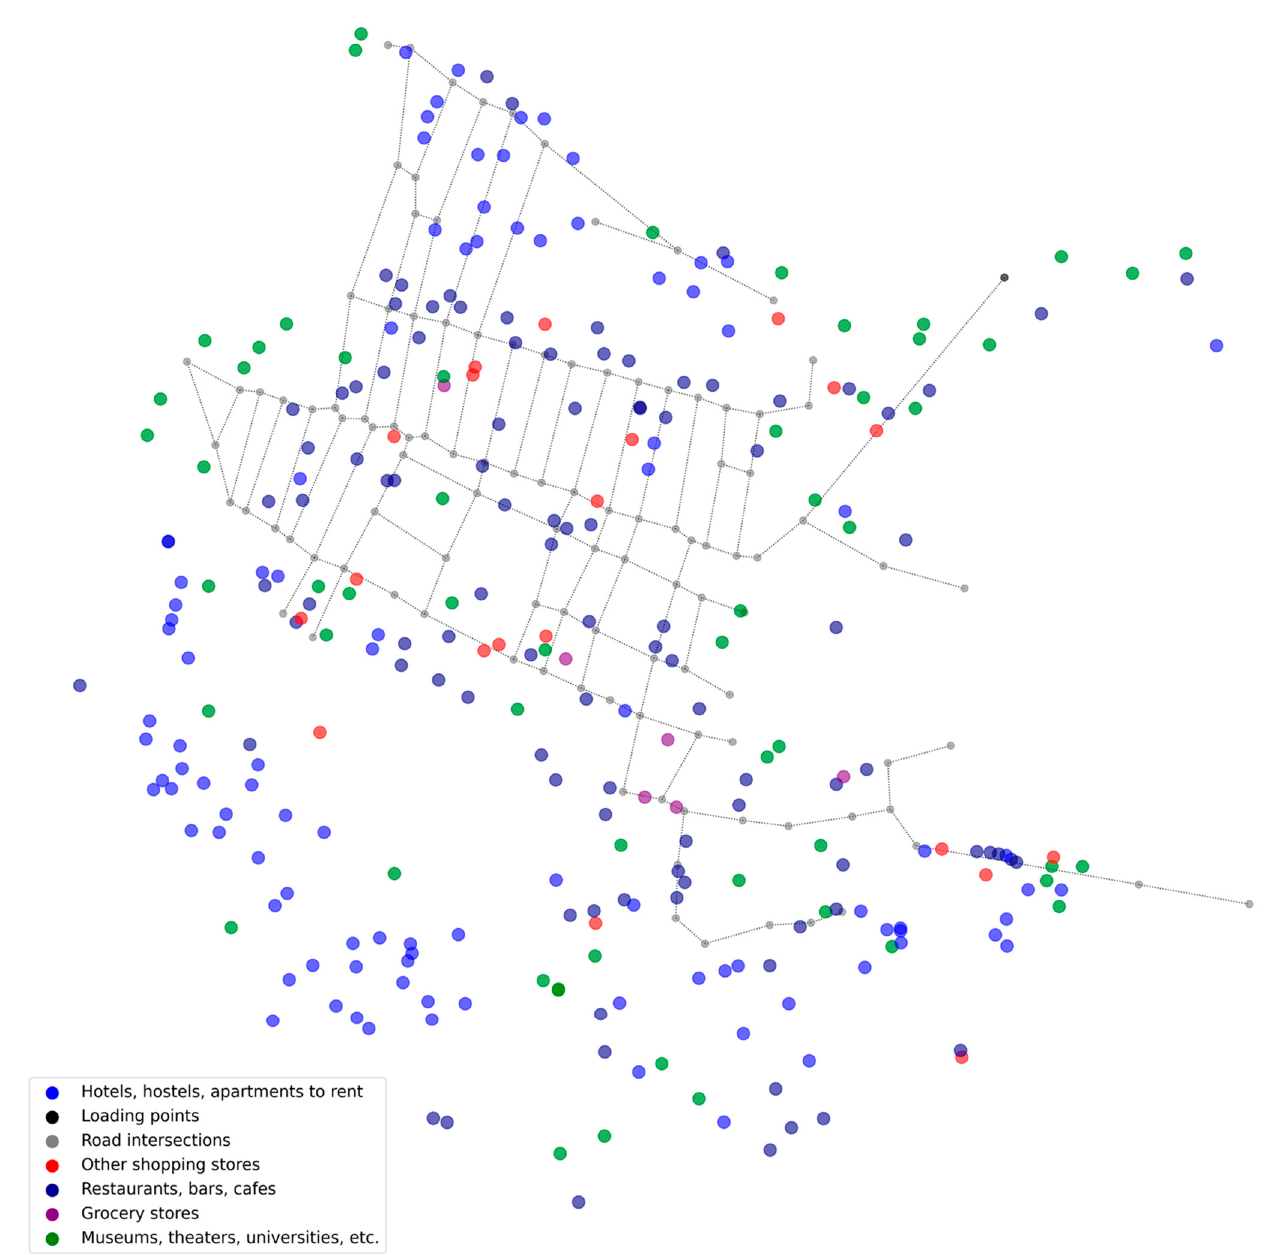
Figure 4. Location of the clients and the road network of the Old Town of Dubrovnik.